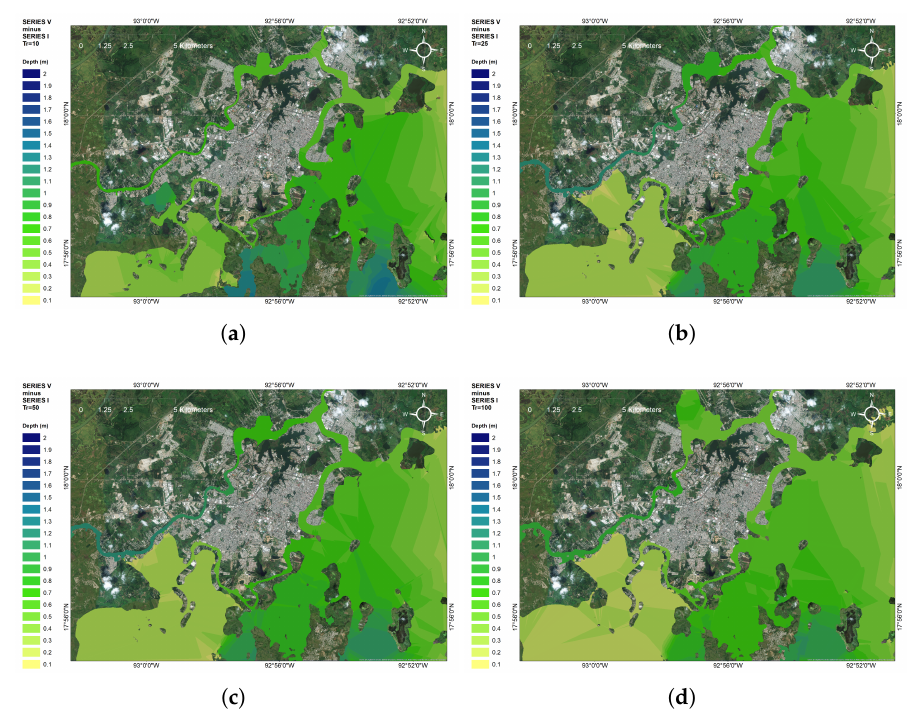
Figure 4. Maps of water depth differences between flood scenarios constructed with the land use data of Series I and Series V. Differences are calculated for the return periods: ( a ) 10 years; ( b ) 25 years; ( c ) 50 years; and ( d ) 100